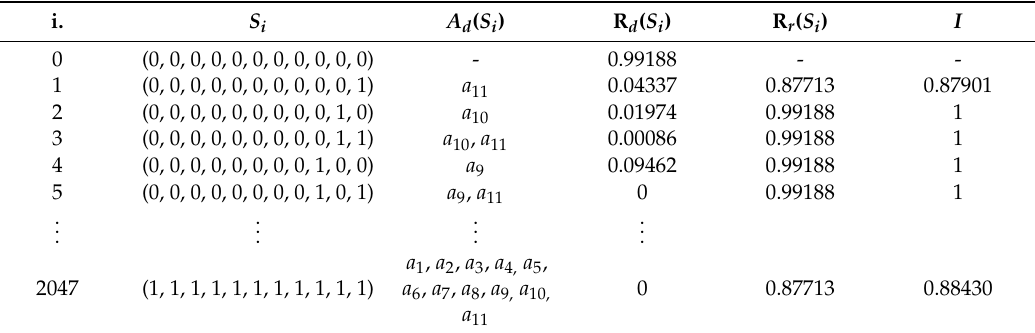
Table 9. All the S i from Figure 5 without recovery cost limit c